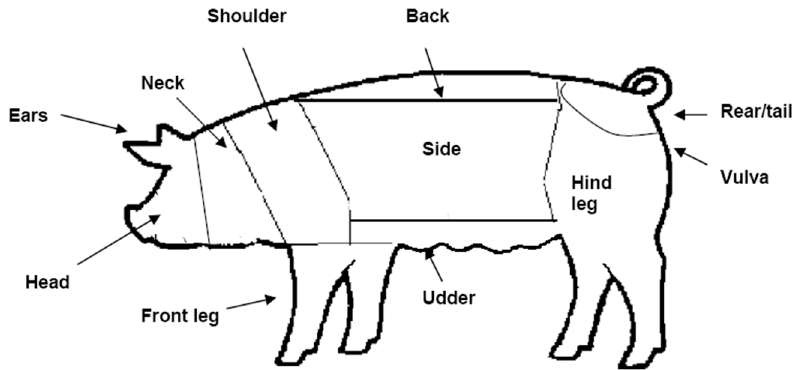
Figure 3. The animal’s body was divided in to 11 areas as illustrated. Each area on both sides was assessed for skin lesions (score = 0 to 3). Adopted from Roy et al. [10]. assessed for skin lesions (score = 0 to 3). Adopted from Roy et al.